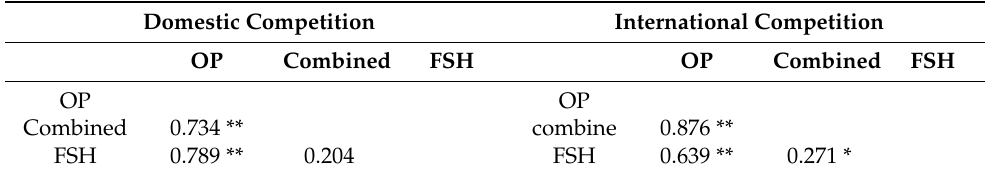
Table 2. Overall performance/combine/(fencing + swimming + horseback riding) Spearman‘